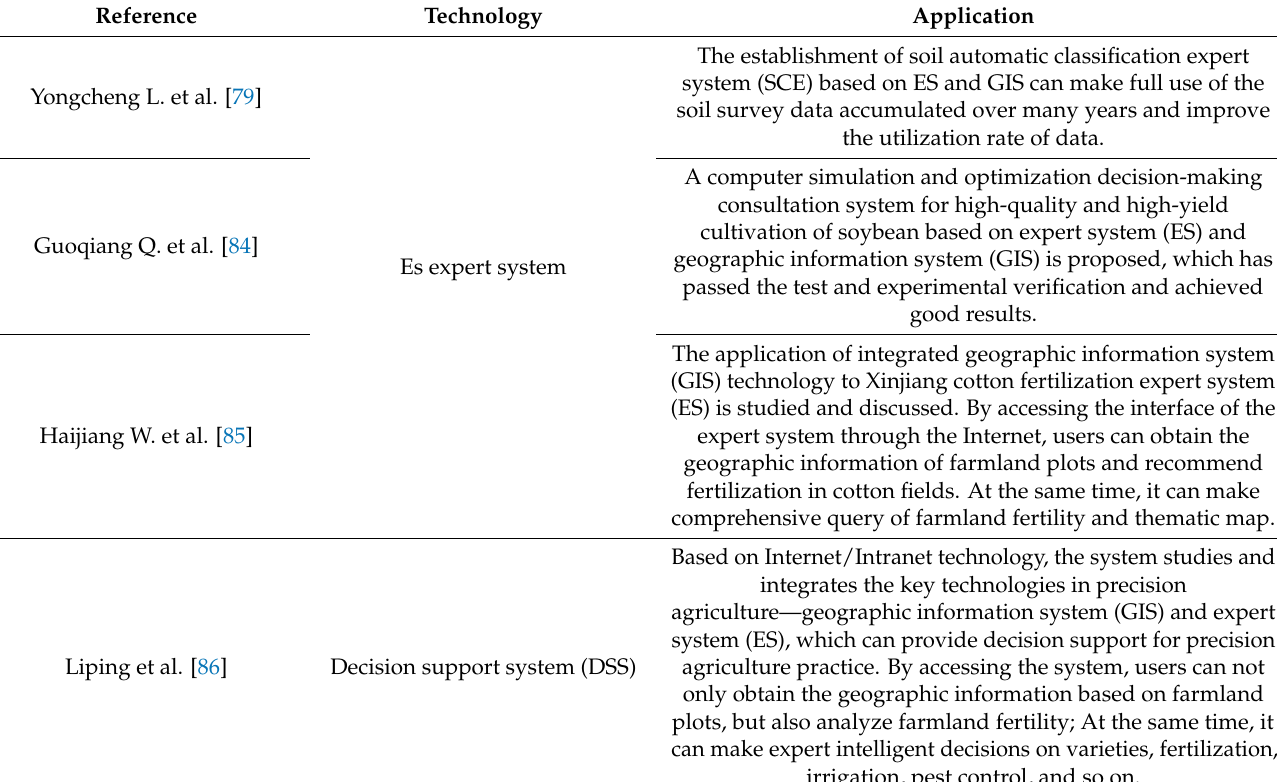
Table 3. Application of decision